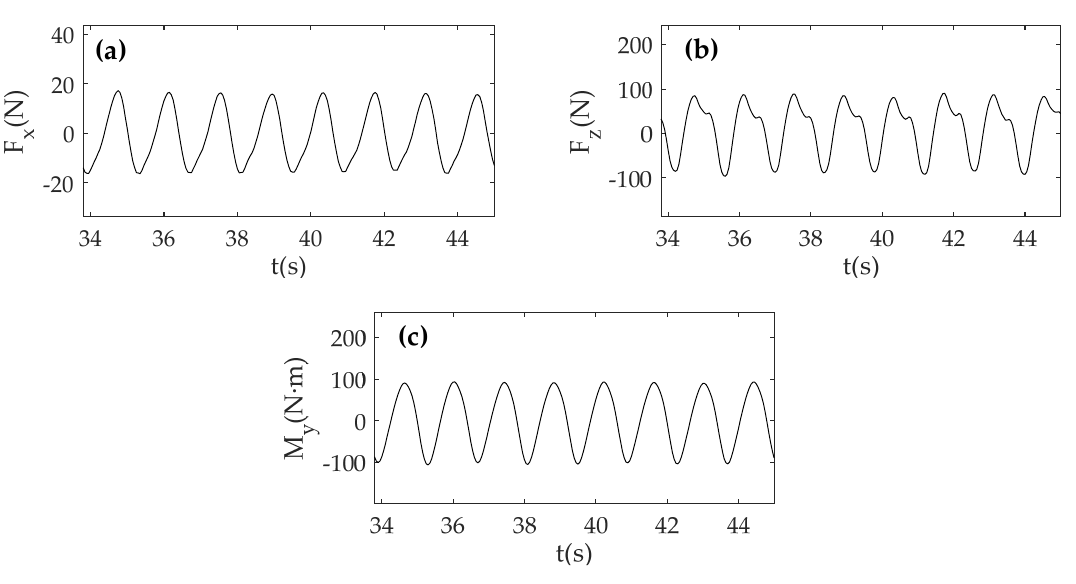
Figure 6. The time series of regular wave forces on a submerged horizontal plate over a flat bottom. (d = 0.14 m, T = 1.40 s and H/h = 0.10.). ( a ) Horizontal forces; ( b ) Vertical forces; ( c ) Overturning = 0.14 m, T = 1.40 s and H / h = 0.10.). ( a ) Horizontal forces; ( b ) Vertical forces; ( c ) Overturning moments.